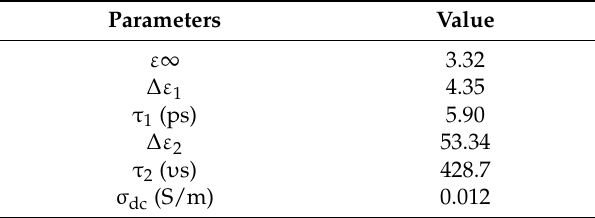
Table 3. Debye model parameters for the loamy soil simulation.